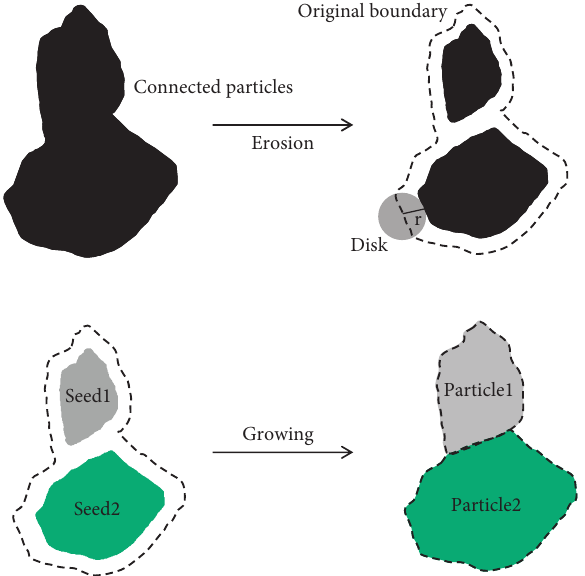
Figure 9: Main steps of the corrosion-flooding process [14].